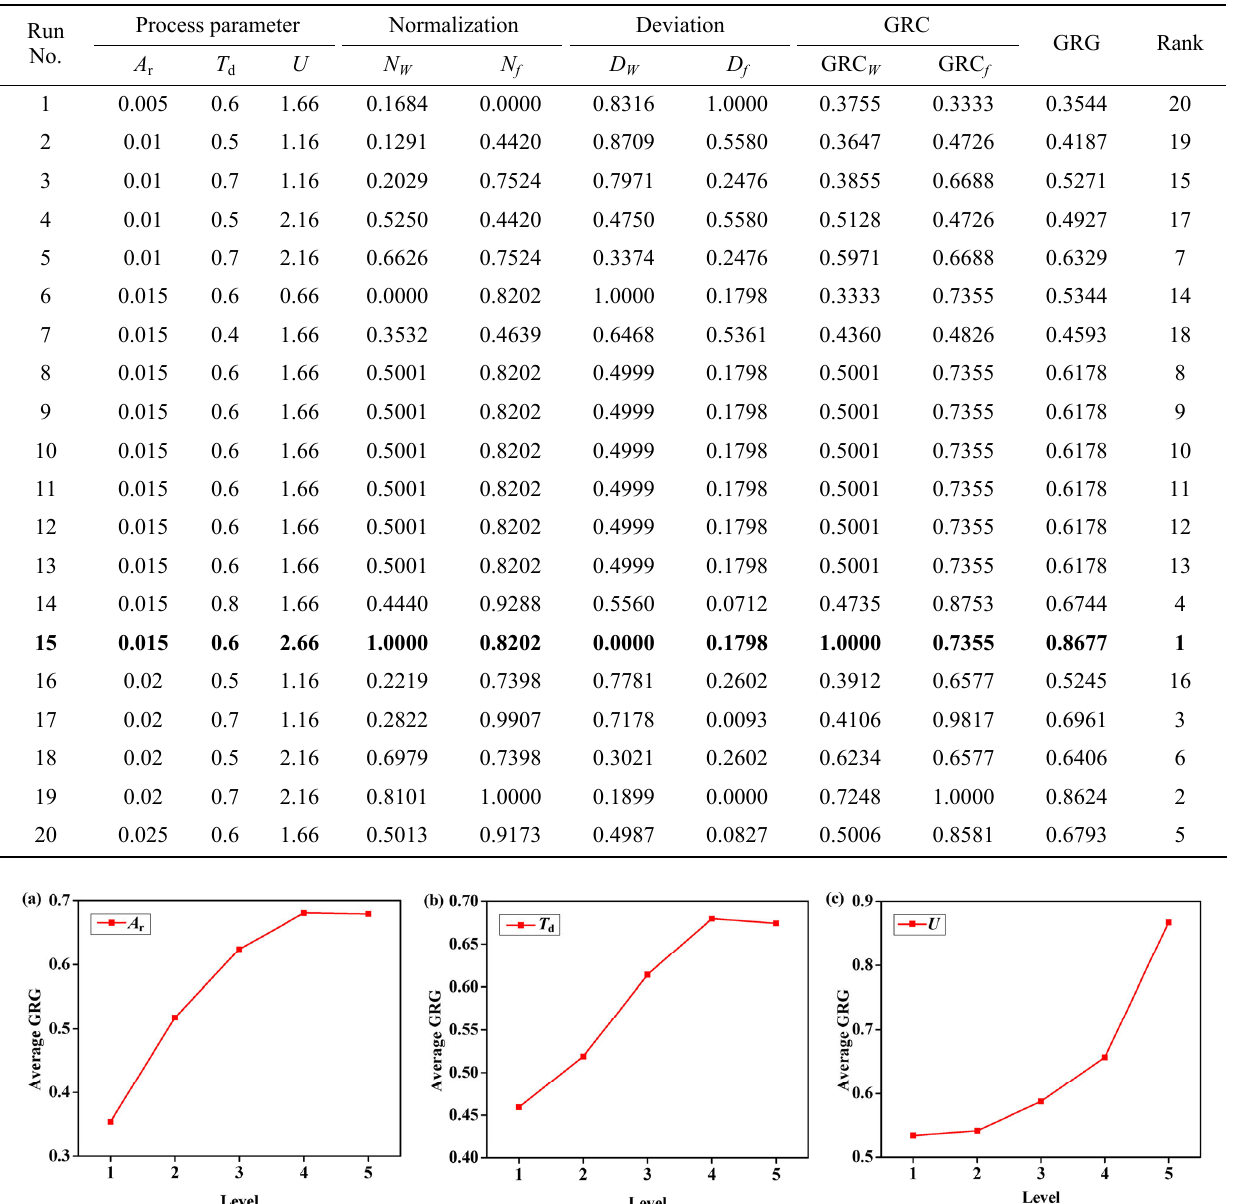
Table 8 GRA of triangle T2 bottom profile.